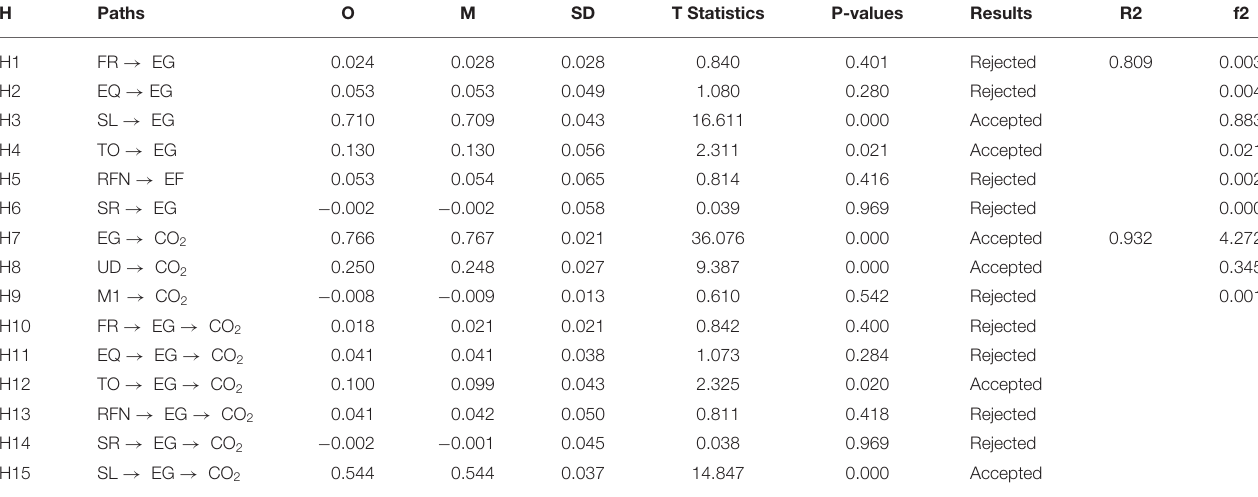
TABLE 4 | Direct and indirect